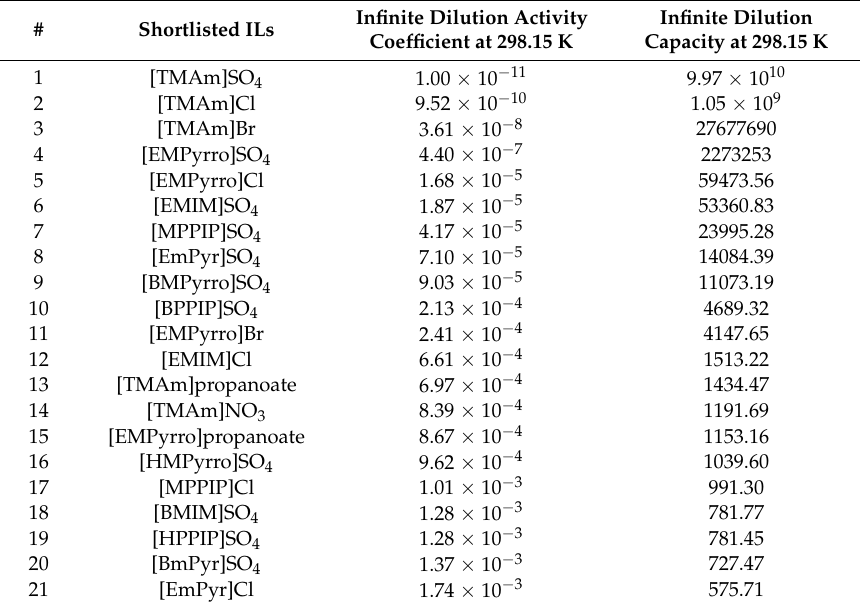
Table 1. Summarize the selective ILs for EPA